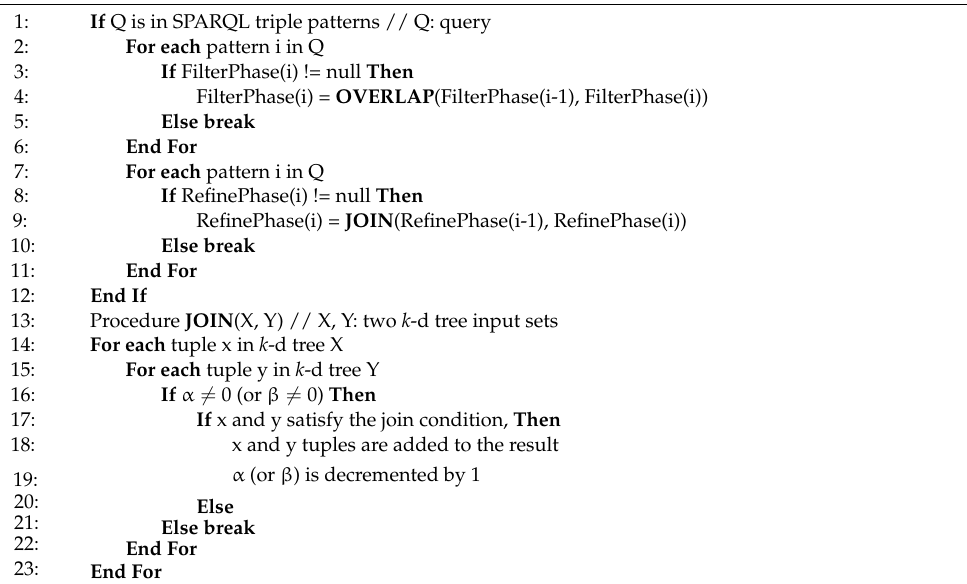
Algorithm 2. MDH*-based join processing.